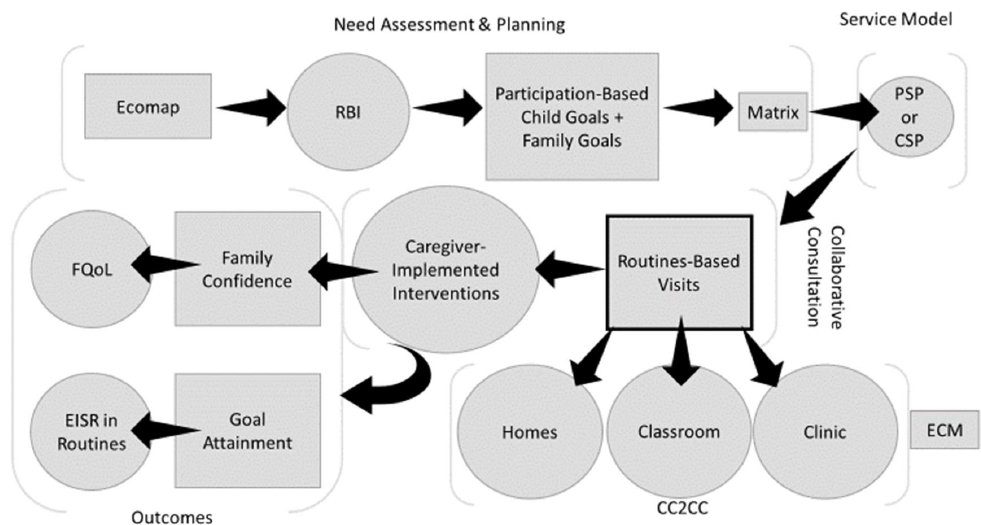
Figure 1. Flow of the Routines-Based Model. RBI: Routines-Based Interview, PSP: primary service provider, CSP: comprehensive service provider, FQoL: family quality of life, EISR: Engagement, Independence, and Social Relationships, ECM: Engagement Classroom Model, CC2CC: collaborative consultation to children’s classrooms.